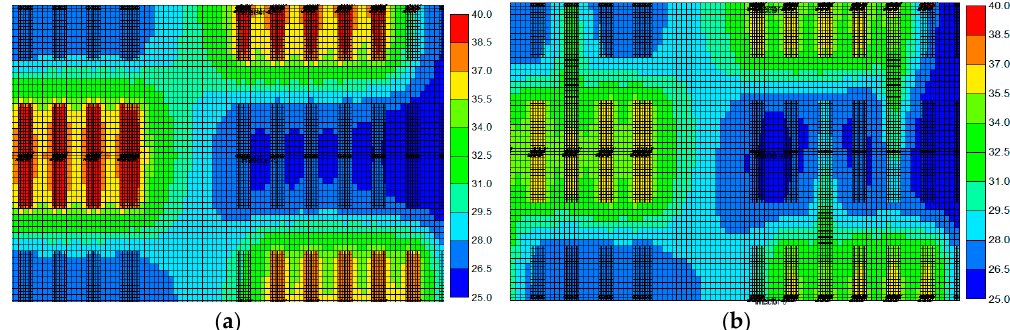
Table 14. Fracture spacing in different schemes.